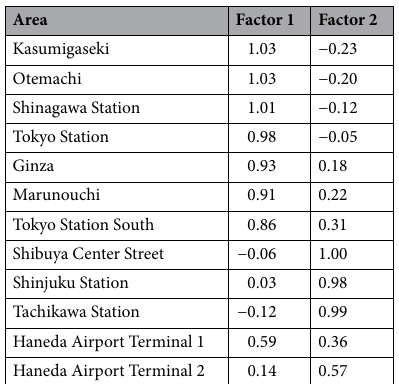
Table 1. Factor analysis of the population ratio of